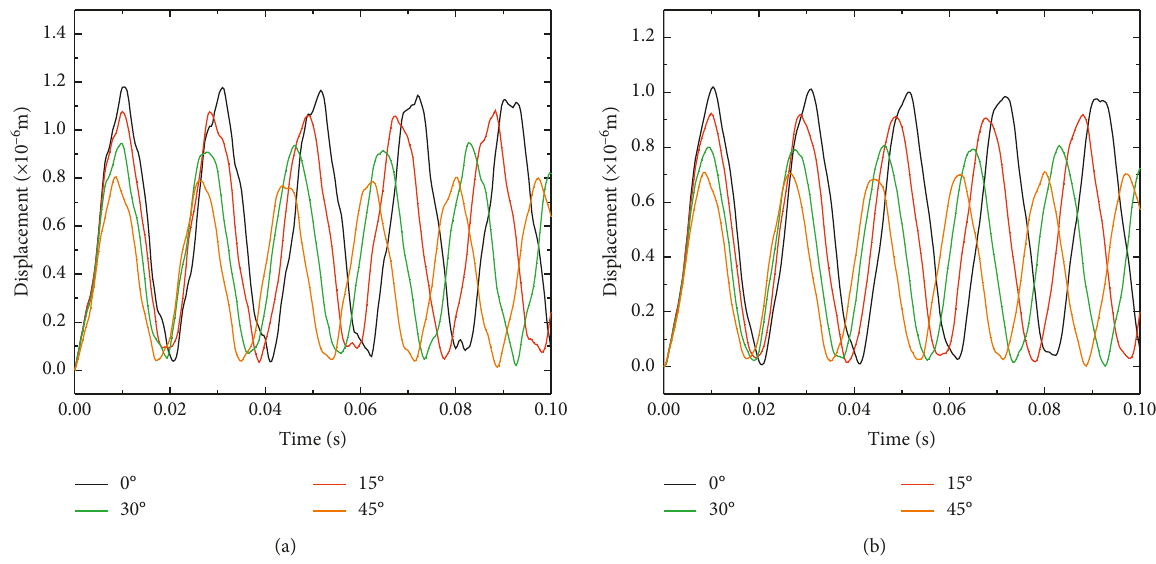
Figure 16: Transient response of an SSSS square plate stiffened by one beam with various orientations ( q (b) Point E (0.4m, 0.4 m).